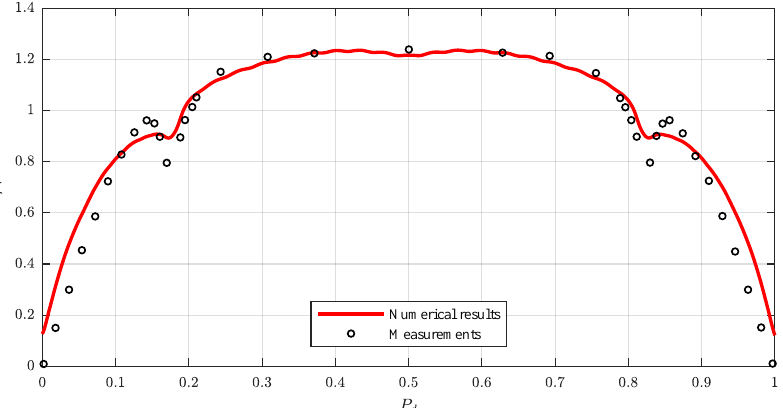
Figure 14. Comparison of calculated and measured boundary shear stress distributions in a smooth trapezoidal channel of the experiments of Lane